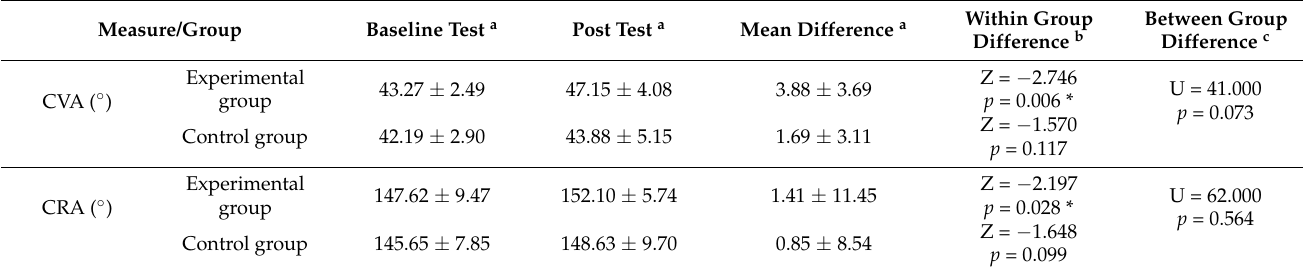
Table 2. Changes of cervical angle on two intervention